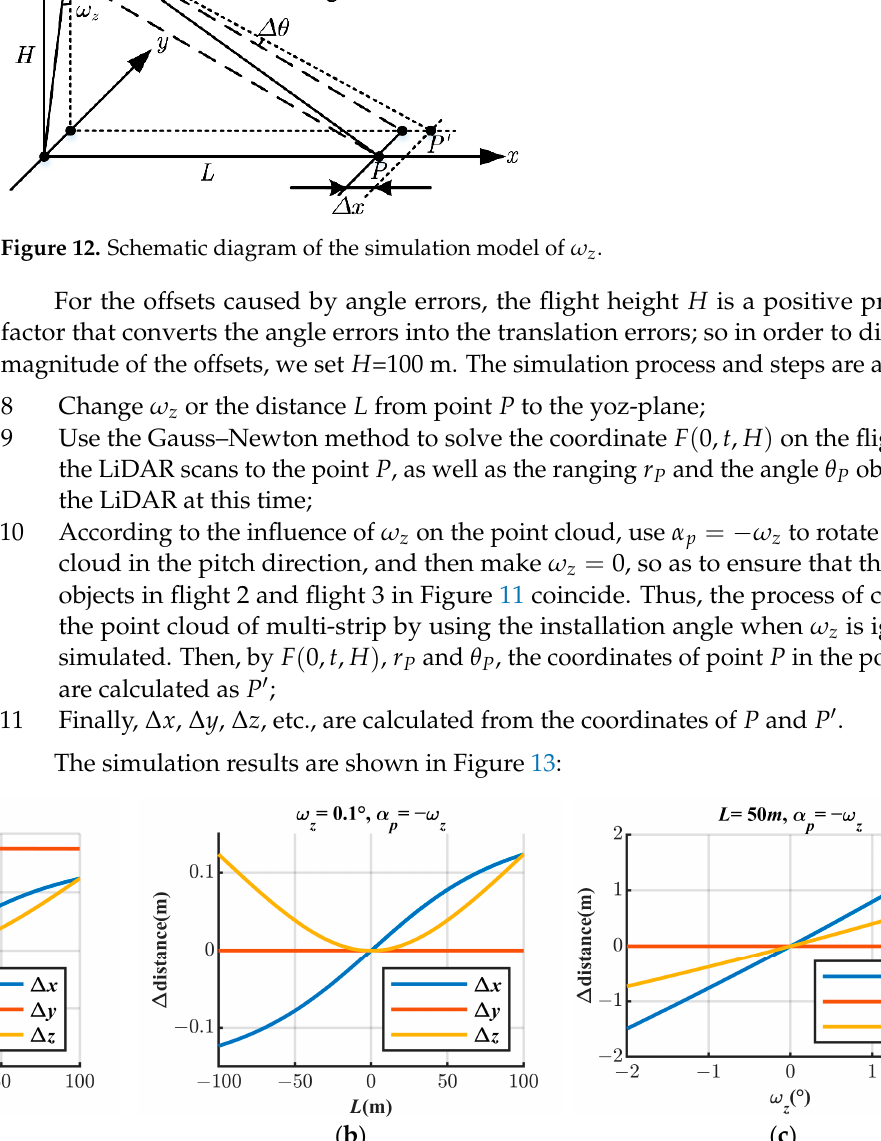
the ranging and angle obtained by the LiDAR are 𝑟 (cid:3017) and 𝜃 (cid:3017) . Since the error angle 𝜔 (cid:3053) is